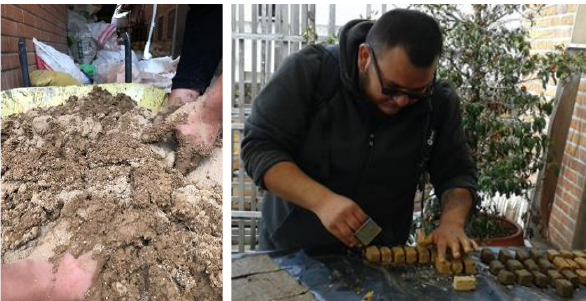
Figure 1.- Process of making bricks on a smaller